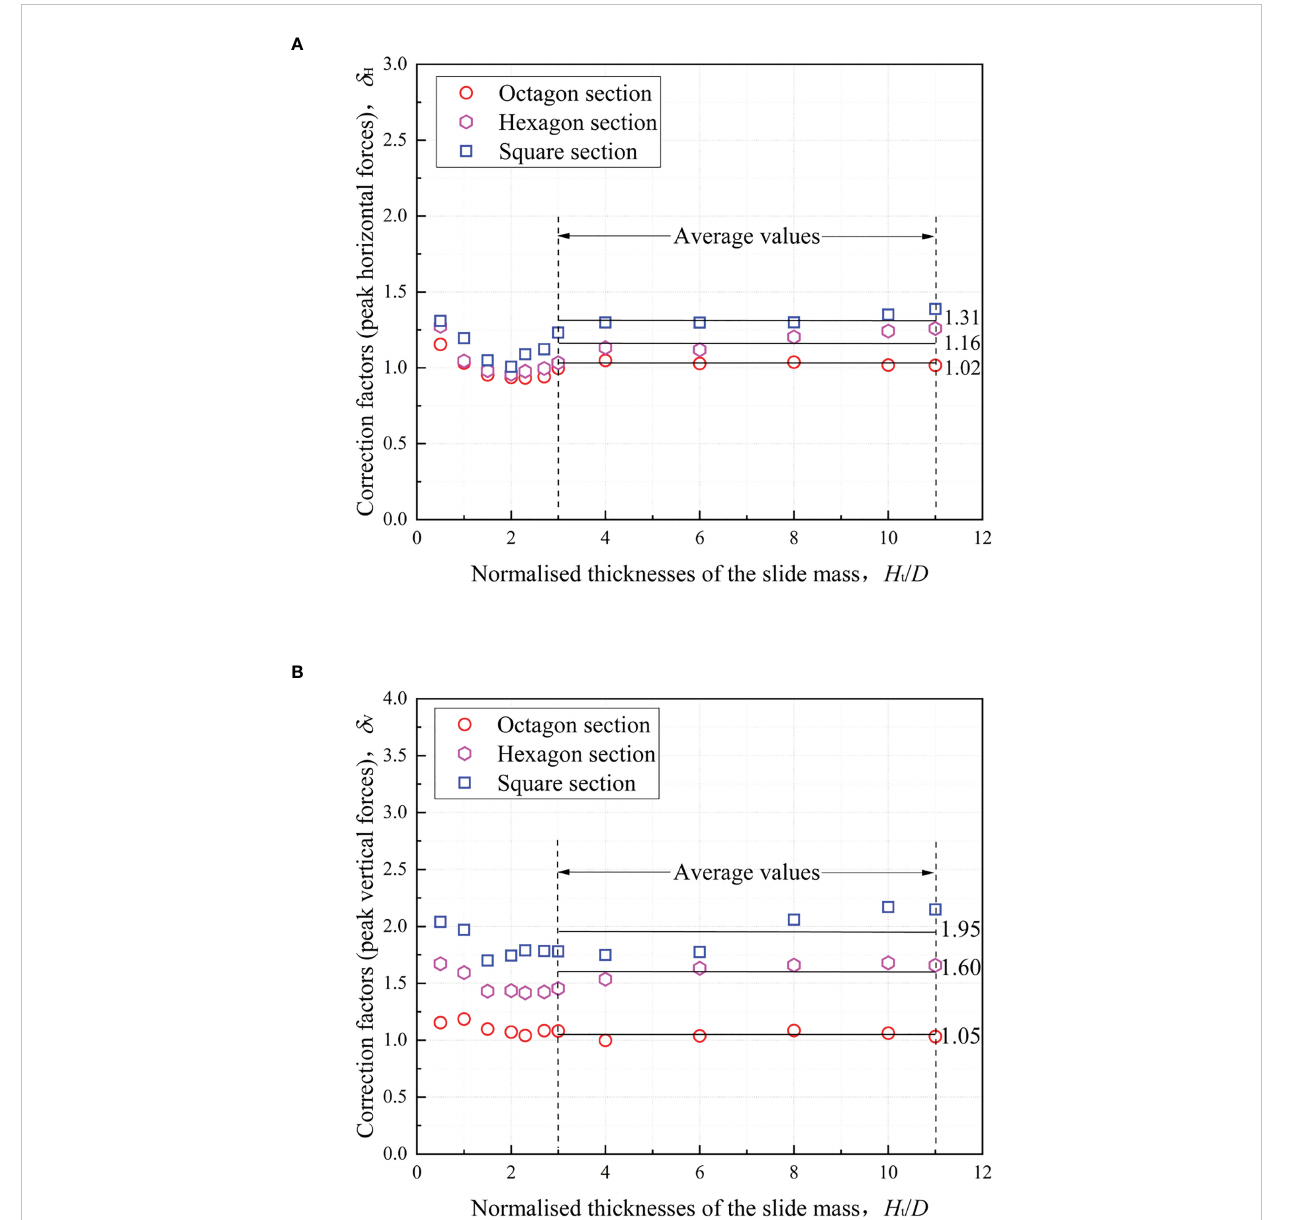
FIGURE 10 Correction factors of the submarine slide impact force: peak horizontal (A) and vertical impact forces (B)